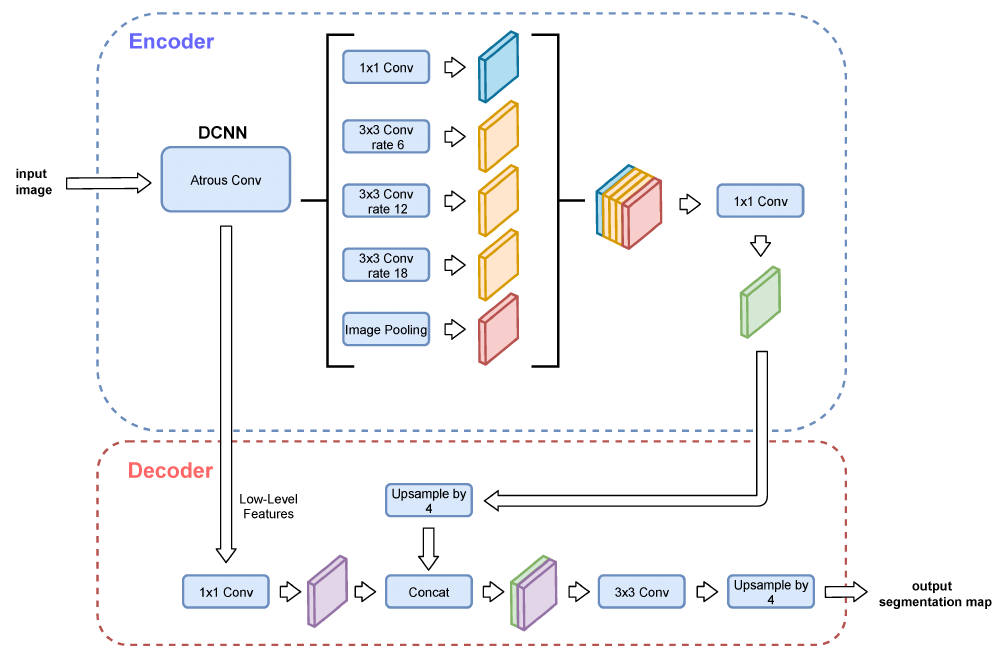
Figure 10. DeepLabv3+ architecture. Source: